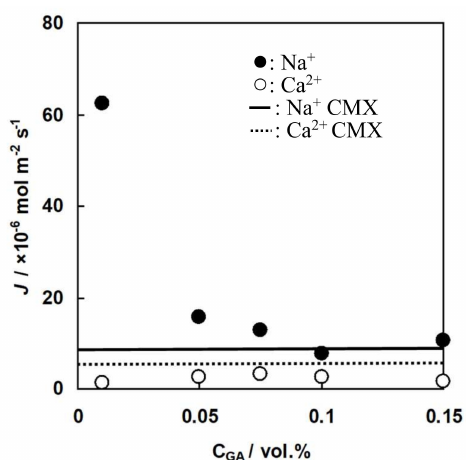
Figure 13. Flux of cations through C-HF membranes, J , as a function of GA concentration. Flux through C-HF membranes: solid circles, Na + ions; open ones, Ca 2+ ions. Flux through CMX: solid line, Na + ions, dotted one, Ca 2+